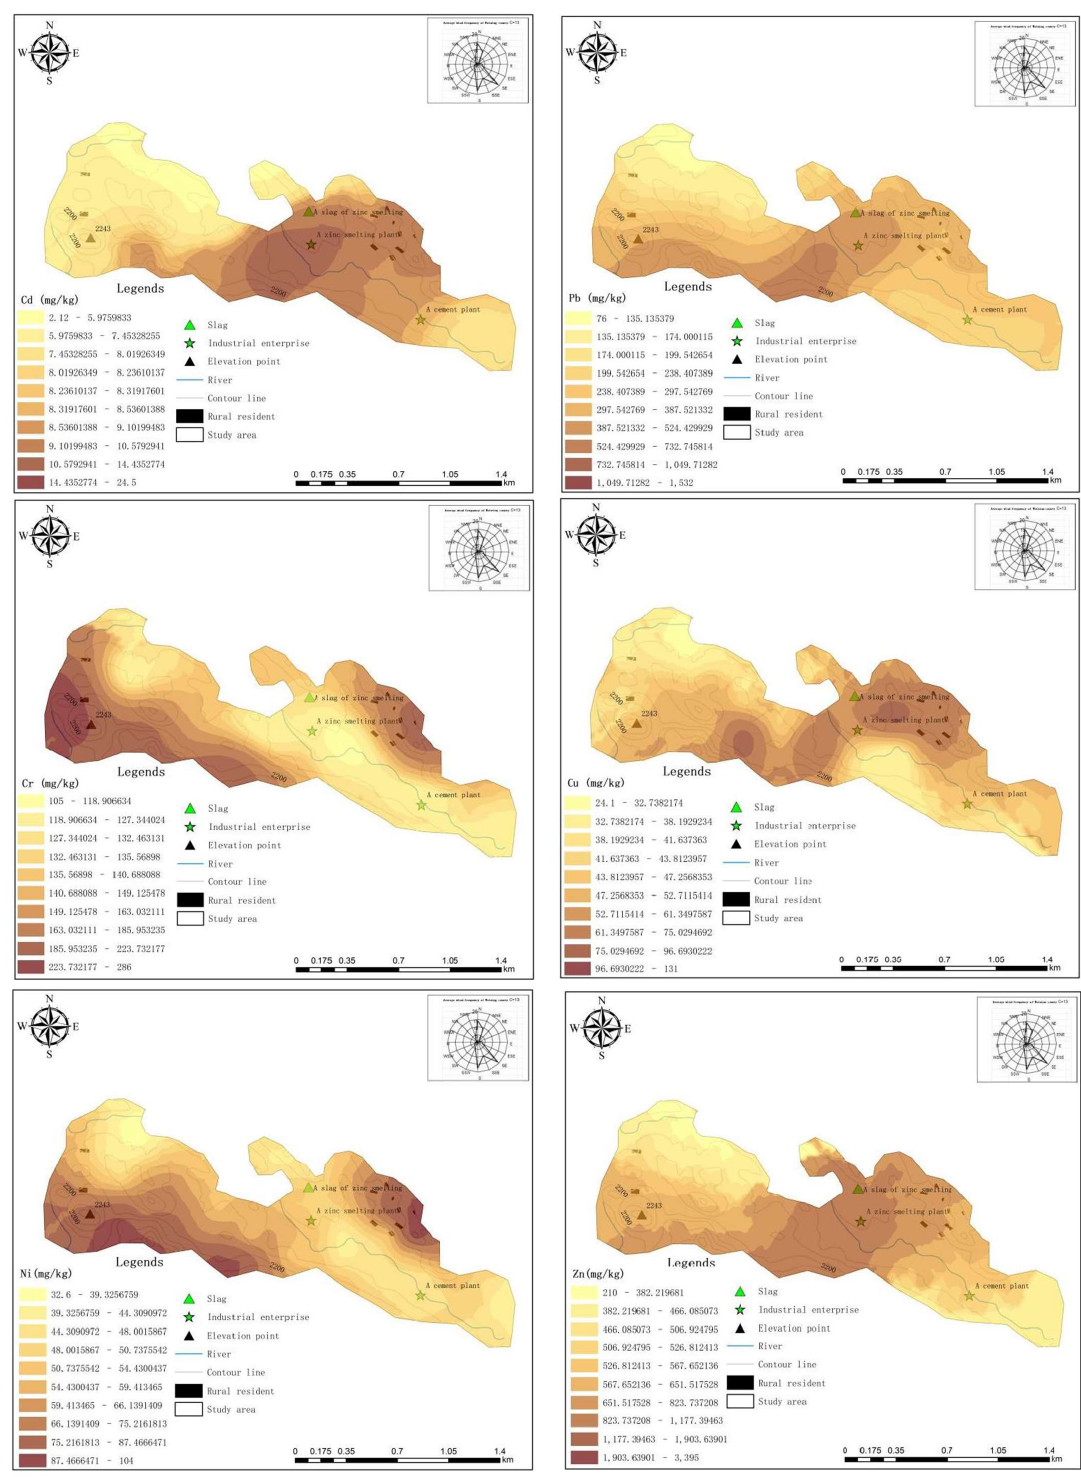
Figure 4. Spatial distribution of Cd, Pb, Cr, Cu, Ni and Zn in surface soil.